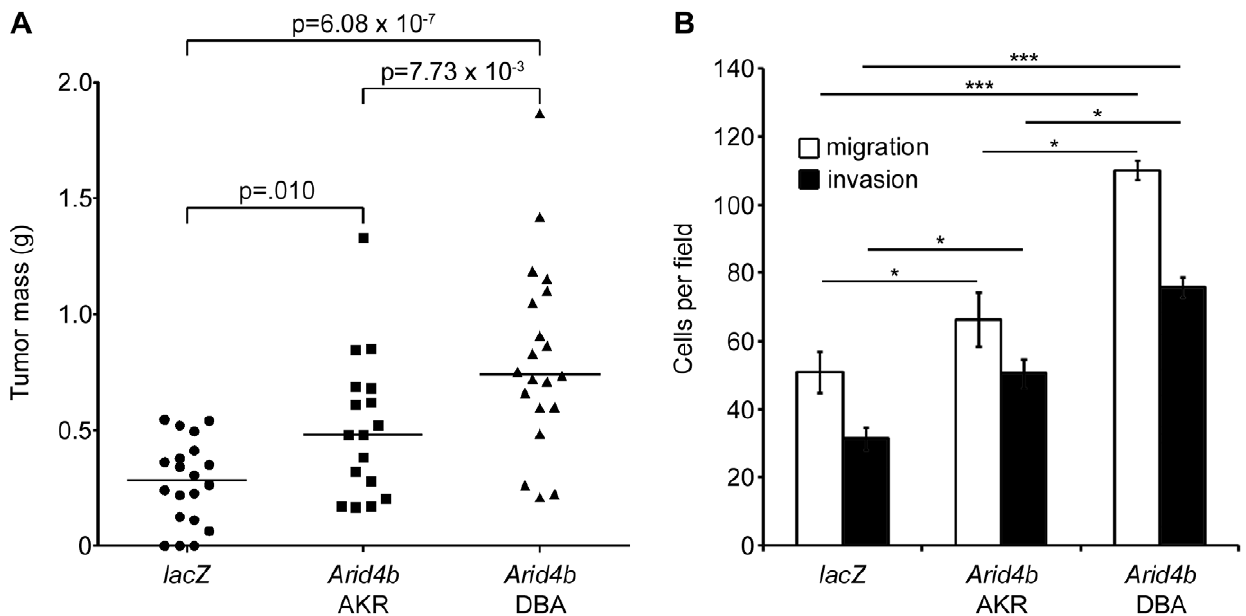
Figure 3. Ectopic expression of Arid4b increases orthotopic tumor growth, tumor cell migration, and invasion. Scatter plot bars represent median tumor mass (A) four weeks after orthotopic implantation of 10 ‘ 5 cells stably expressing lacZ (n=20), Arid4b AKR allele (n=17) or Arid4b DBA allele (n=20). Migrating and invading cells (B) were counted in five 400 6 fields per experiment and data are presented as the mean 6 standard error of three independent experiments. Statistical significance was determined using Kruskal-Wallis tests followed by Conover-Inman post hoc tests. *, p , 0.05; ***, p , 0.001.